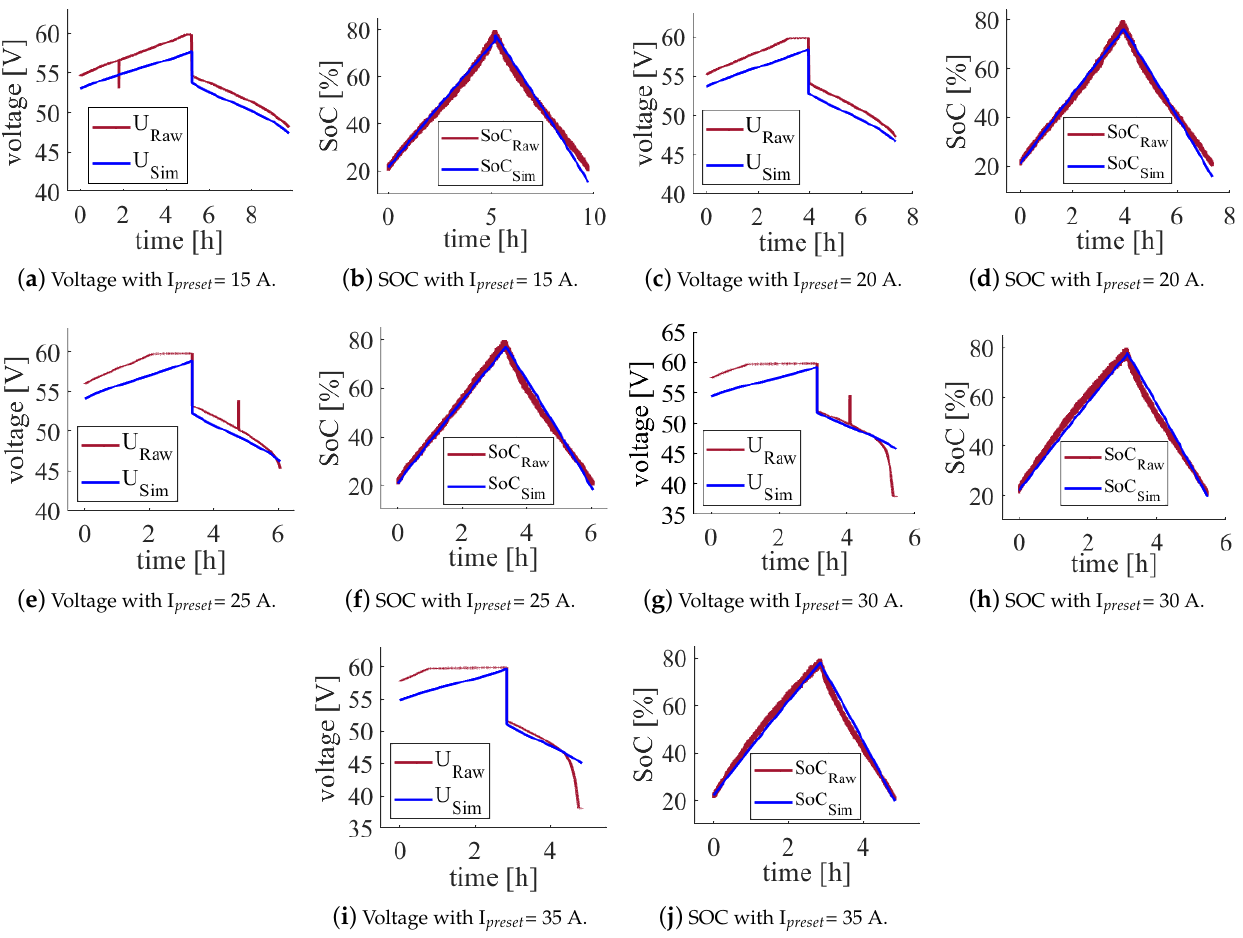
Figure 9. Comparison of the original raw data with the simulation data with preset current I preset from 15 A to 35 A based on SOC and